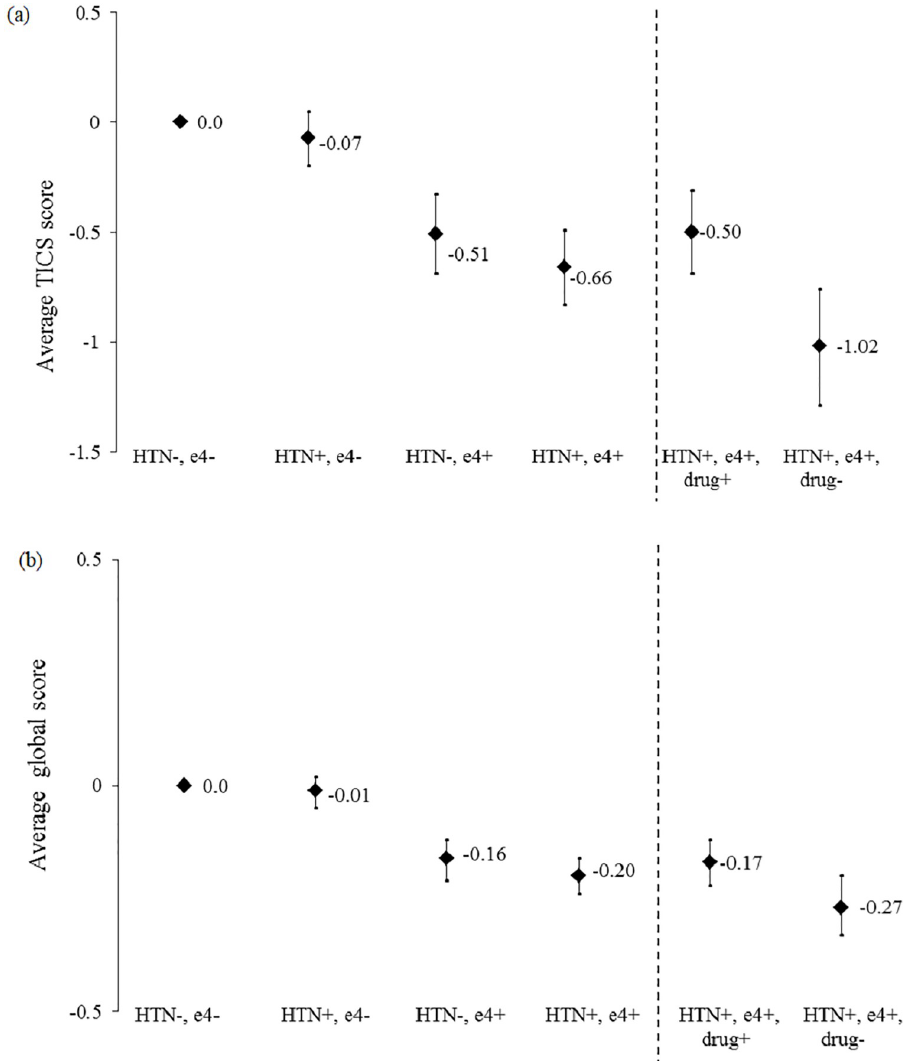
Fig 2. Adjusted mean differences in (a) average TICS score and (b) average global score according to categories of physician-diagnosed hypertension (“HTN”) and apolipoprotein e4 genotypes. P -for interactions between APOE e4 and treated HTN were 0.61 and 0.71, respectively; P -for interactions between APOE e4 and untreated HTN were 0.02 and 0.045,